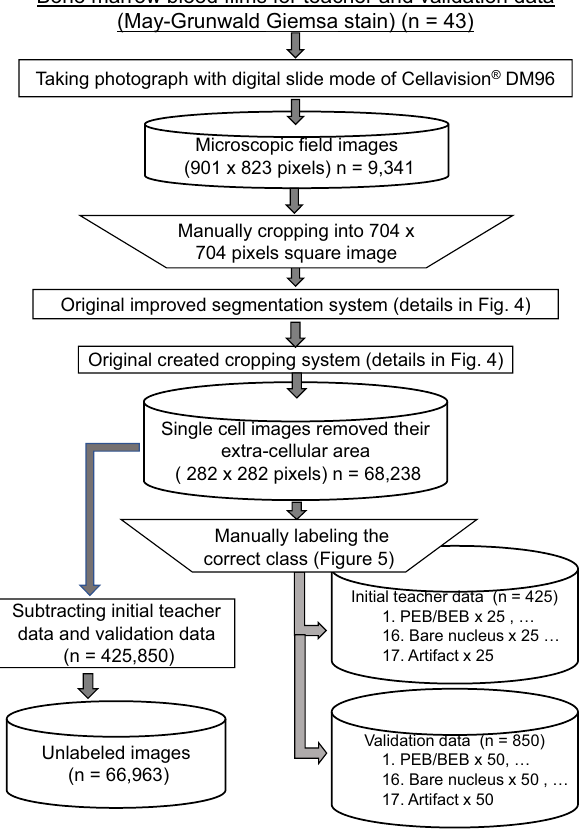
Figure 6. Examples of the 17 classes of bone marrow cells in this study. For classes of proerythroblast/ basophilic erythroblast and basophil/mastocyte, only an image of the first label of the cell is shown in this figure.